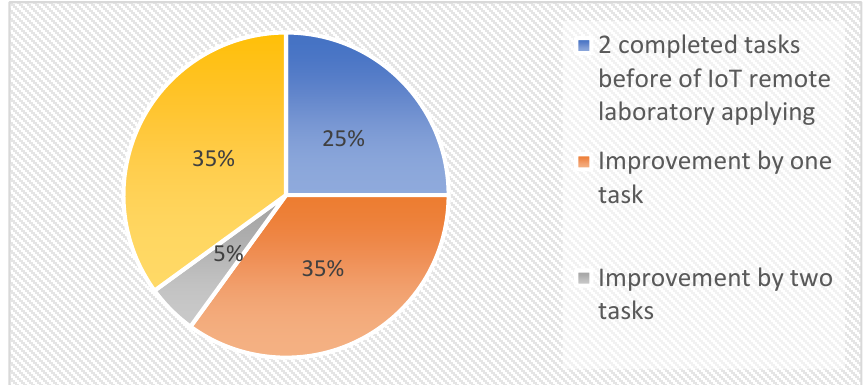
Figure 15. Graph of task improvement after IoT remote laboratory application.